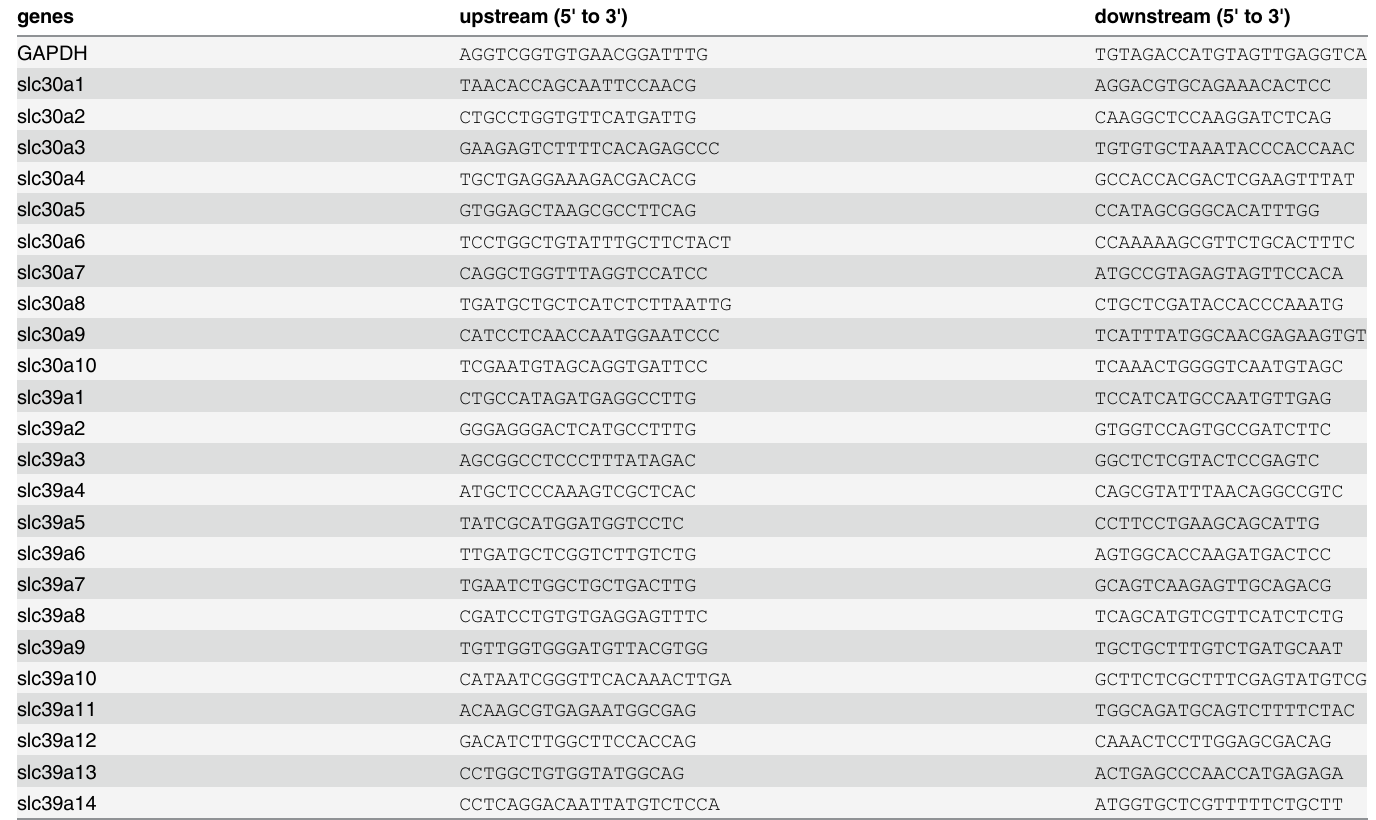
Table 1. Primers used in this